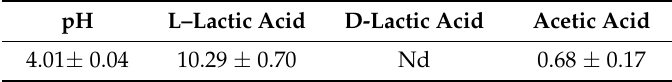
Table 2. Final pH and production of organic acids (mg/mL; mean ± SD) in an MRS broth by L. salivarius PS7.